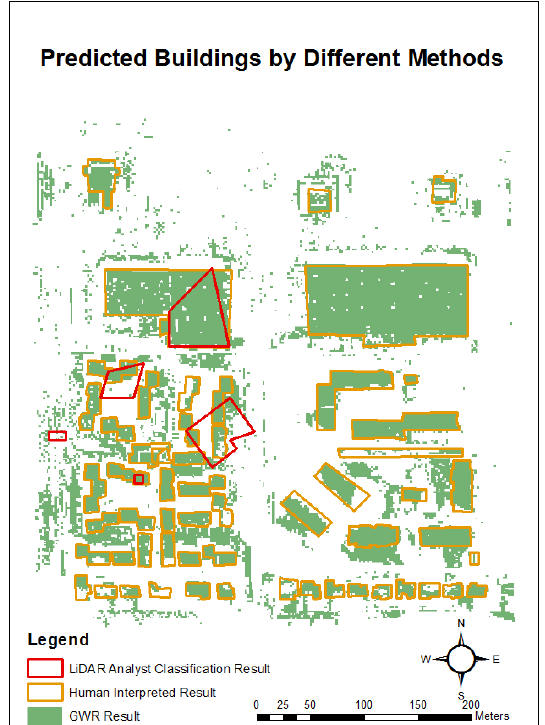
Figure 10. Predicted Buildings by Different